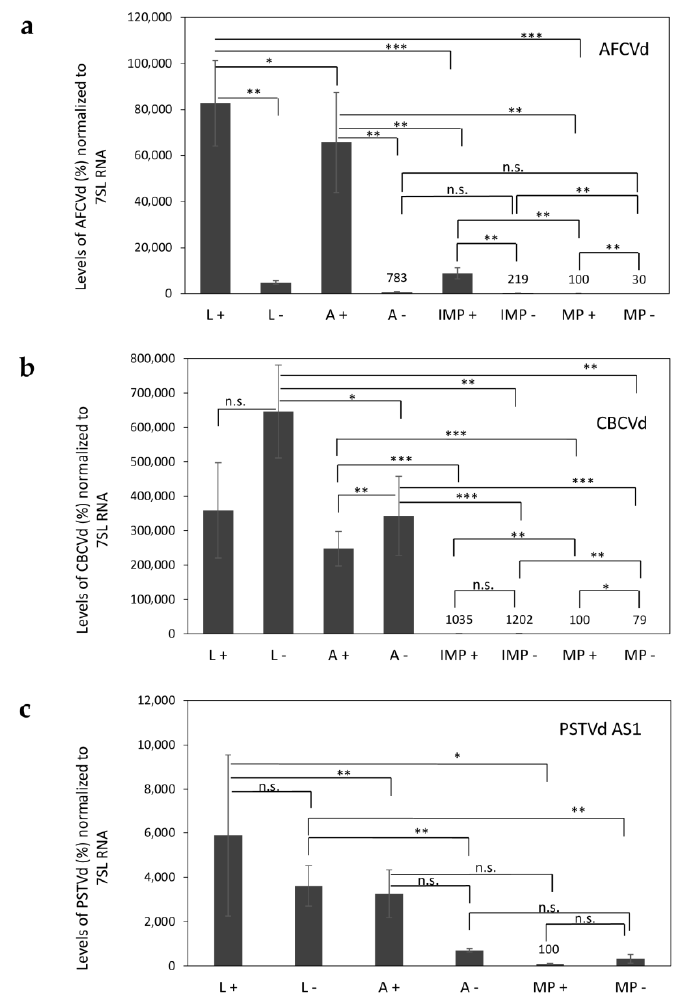
Figure 2. Relative levels of viroid (+) and ( − ) RNA chains in young leaves (L), immature anthers stages 3 – 4 (A), isolated immature pollen stages 3 – 4 (IMP) and mature pollen (MP) of N . benthamiana plants, which were inoculated by A. tumefaciens infiltration using infectious dimeric viroid cDNA-bearing plant vectors for ( a ) AFCVd, ( b ) CBCVd and ( c ) PSTVd AS1. Samples were collected 20 days p.i. and analyzed using ssRT-qPCR for relative levels of (+) and ( − ) chains. IMP was not collected from plants infected with PSTVd AS1. Healthy plants showed no qPCR signals of specific viroid. Each column represents the mean ± S.D. of two replicates of each PCR reaction. Lines with asterisks (* p < 0.1; ** p < 0.05; *** p < 0.01) indicate significant differences between connected values; (n.s.) statistically non-significant differences at p > 0.1. Remaining p values, which did not fit to the